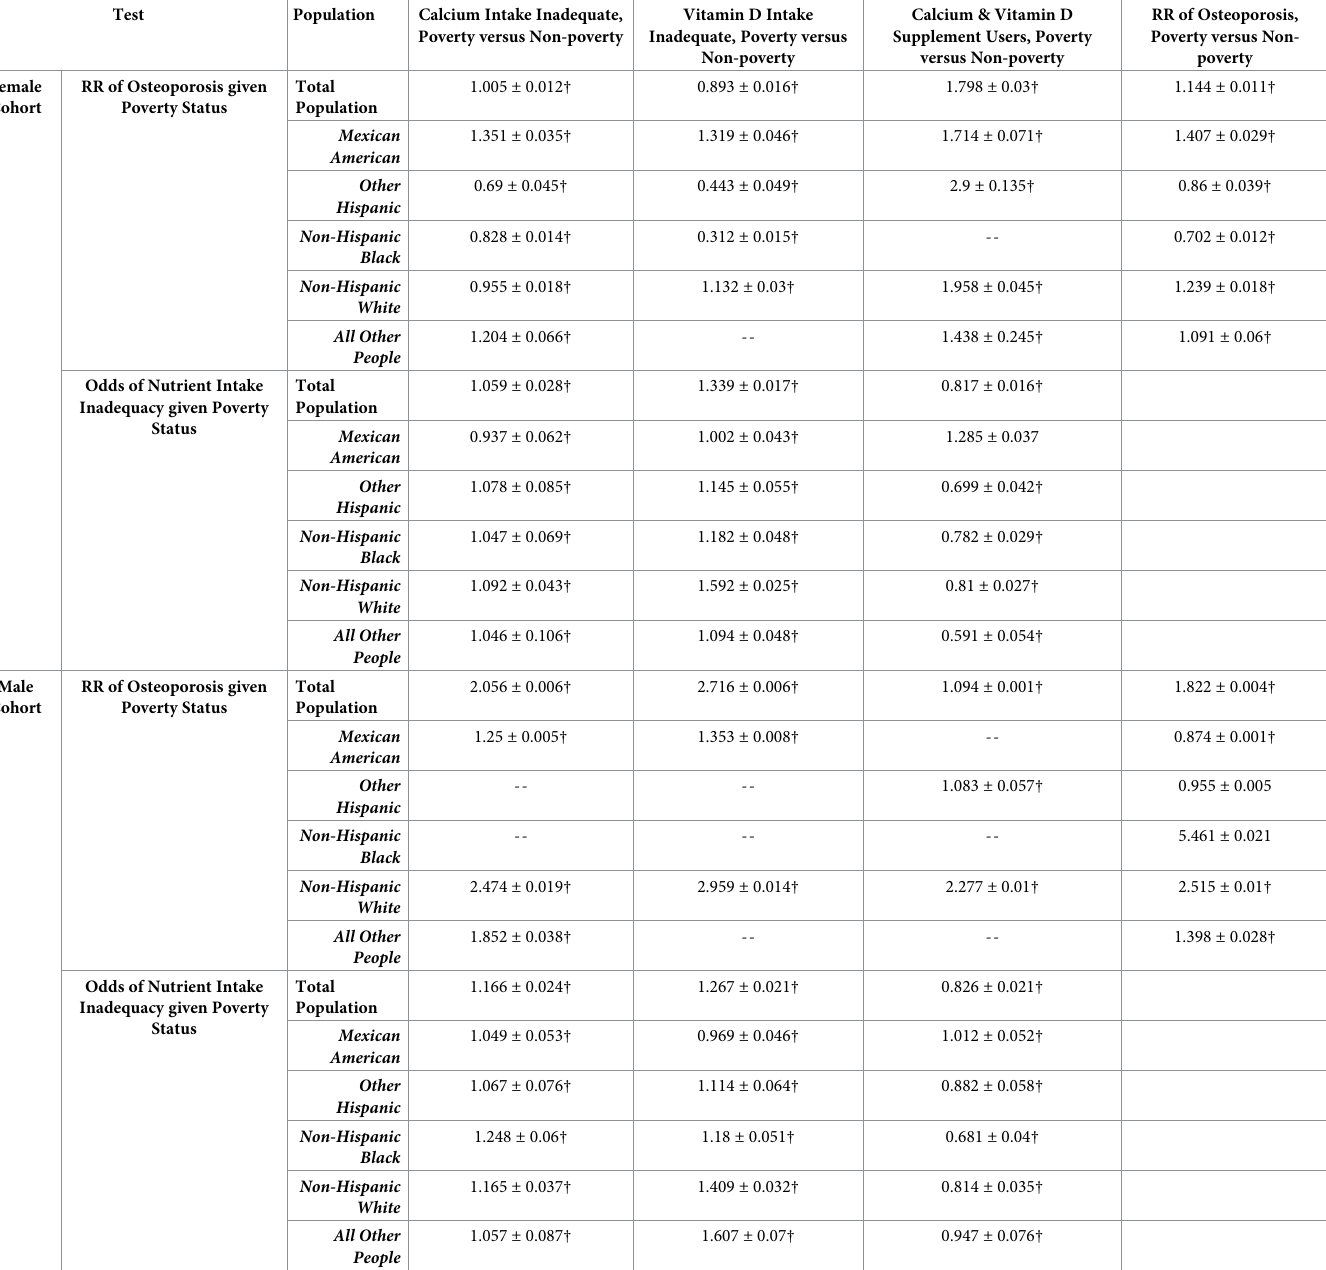
Table 4. Influence of poverty status on RR of nutrient intake & osteoporosis with analysis by ethnicity and gender, age 50 and